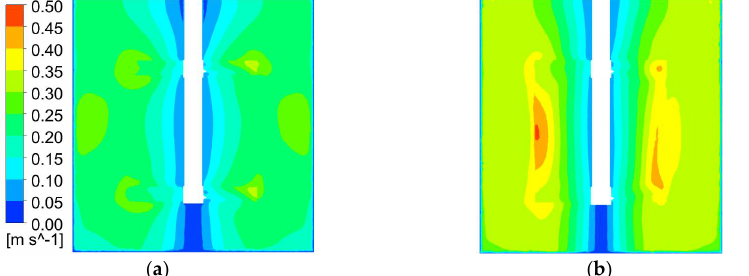
Figure 9. Contour plots of velocity distribution for different impeller types. ( a ) DTBI; ( b ) DRFTBI. (Rotational speed: 120 rpm, Solid loading: 30%, Connection strap length: 1.2 H S , Plane: X = 0).